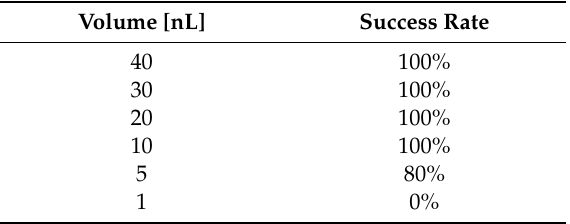
Table 1. Influence of volume of droplet on alignment.